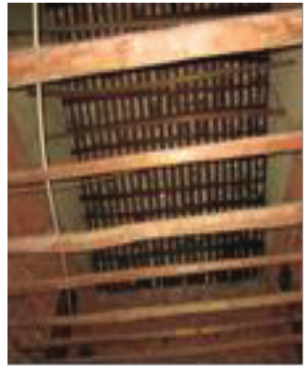
Figure 4: Roof truss